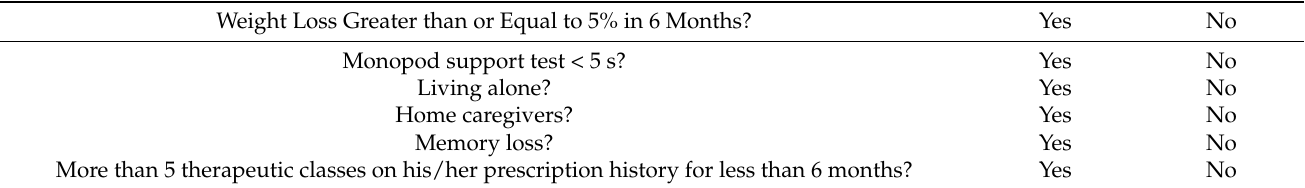
Table 1. Zulfiqar Frailty Scale